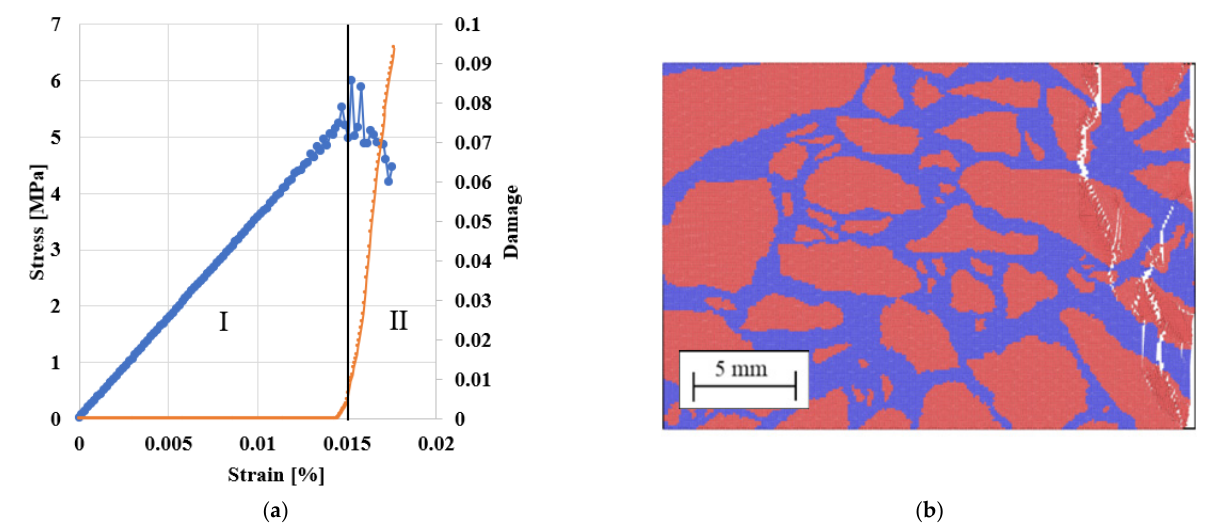
Figure 10. ( a ) Stress (blue curve) and the fraction of broken bond (damage, orange curve) versus strain. ( b ) Micro-crack formation in an asphalt specimen.